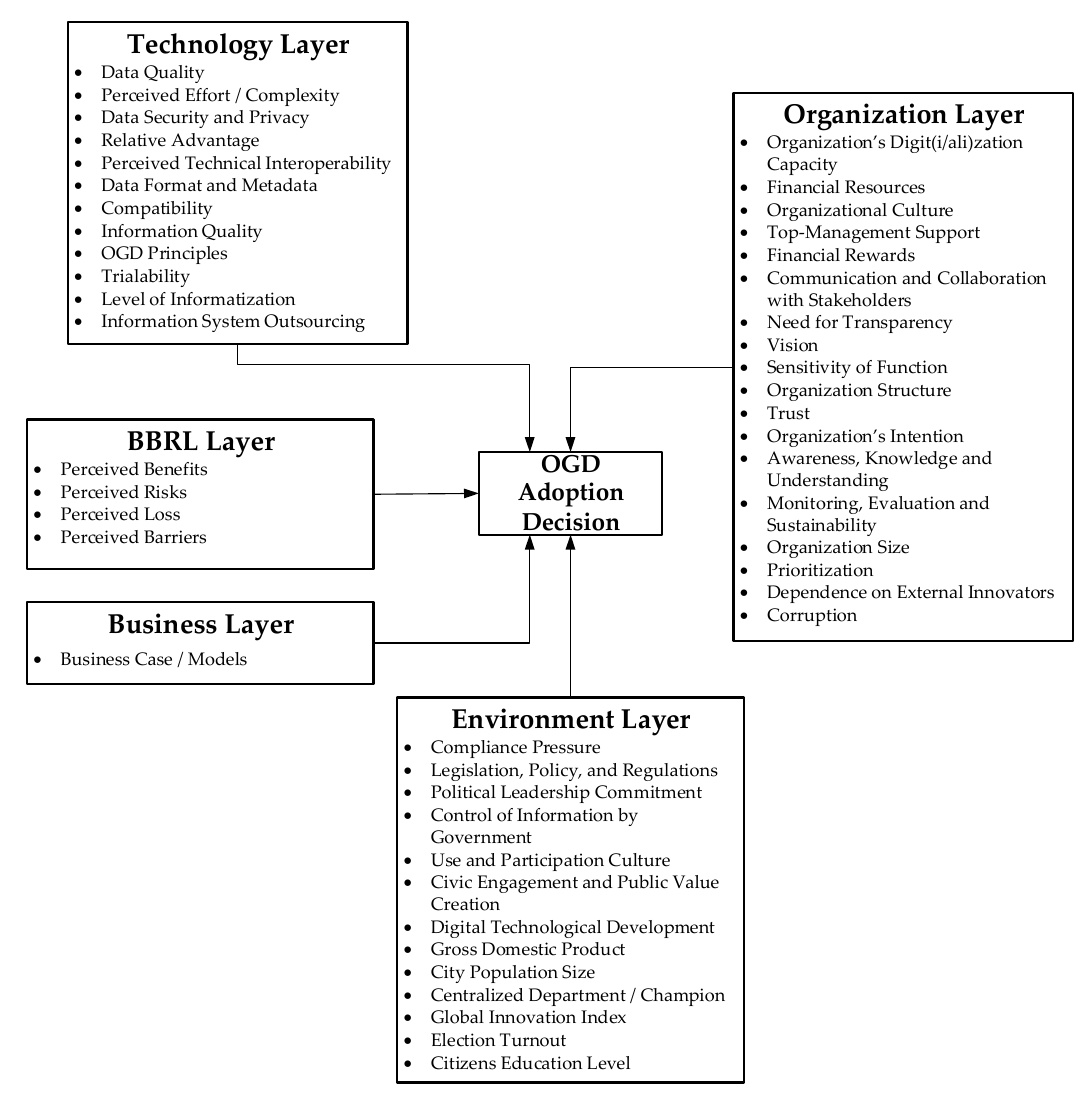
Figure 3. Proposed Model.